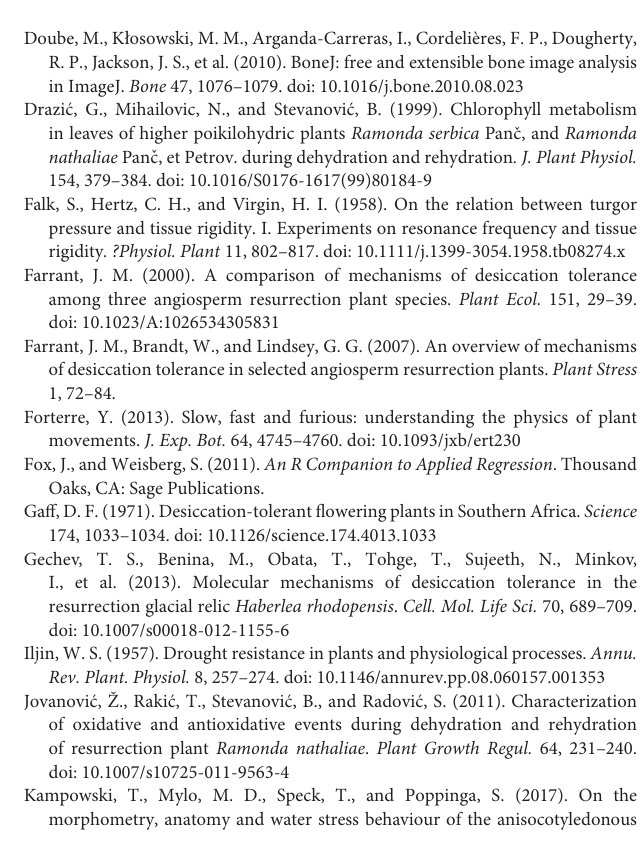
Video S3 | Repeatability of DRE-specific plant movements. The video shows three consecutive DREs of the same cut-off R. myconi leaf. Video S4 | DRE-specific leaf vein movements. The video shows the plant movements that are only related to DRE-specific alterations within the leaf’s venation system. Video S5 | DRE-specific 2D lamina and petiole movements. The video shows the DRE-specific two-dimensional movements of the leaf lamina separated from its petiole and venation system. Figure S1 | Texture and venation pattern of a fully hydrated R. myconi leaf. (A) Side view of the leaf. (B) Top view of the leaf. The leaf displays a pronounced waviness and a very complex pattern of higher order leaf veins. Additionally, the strong leaf pubescence is clearly visible. Figure S2 | Longitudinal thin sections of the leaf petiole of R. myconi . (A) Longitudinal cut of a R. myconi leaf petiole stained with toluidine-blue. (B) Close-up of the thin section shown in A. Except for the elongated lignified vascular tissues, the cells of all tissue types are more or less isodiametric in longitudinal direction. Figure S3 | Additional transverse thin sections of the leaf petiole and the leaf lamina of R. myconi . (A) Cross-section of a leaf petiole stained with Toluidine-Blue. (B) Cross-section of a leaf petiole stained with Phloroglucin-HCl to highlight lignified tissues. (C) Close-up of a transversally cut vascular strand of the petiole (Phloroglucin-HCl staining). (D) Close-up of a transversally cut vascular complex of the petiole (Phloroglucin-HCl staining). (E) Cross-section of a leaf lamina stained with Toluidine-Blue. (F) Close-up of a transversally cut leaf lamina (midrib region) stained with Phloroglucin-HCl. (G) Close-up of a transversally cut vascular complex of the lamina (Phloroglucin-HCl staining). (H) Close-up of a transversally cut vascular strand of the lamina (Phloroglucin-HCl staining). Table S1 | Measured